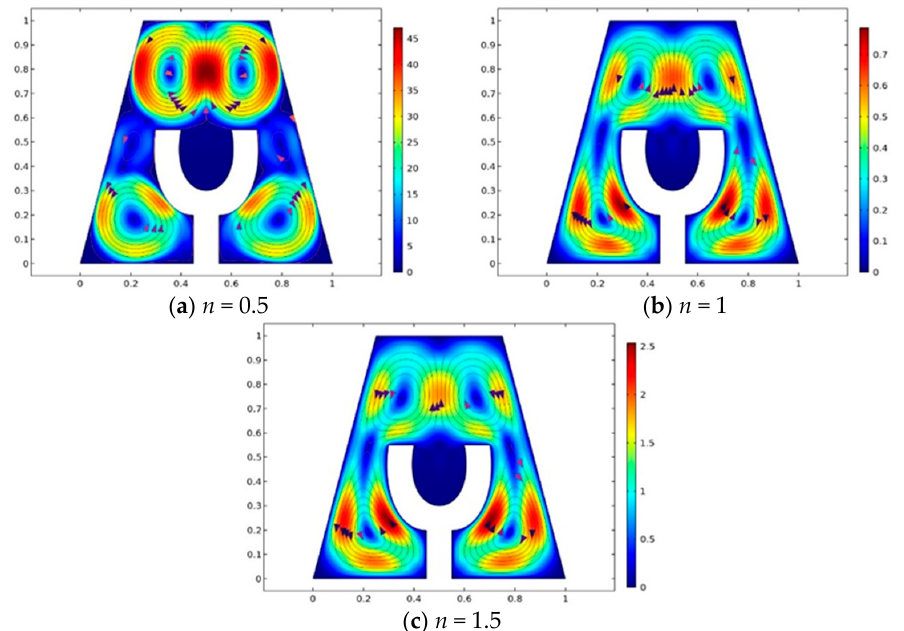
Figure 3. Velocity profiles and streamlines for varying power law index ( n ) for Ra = 1000 and Pr = 5.